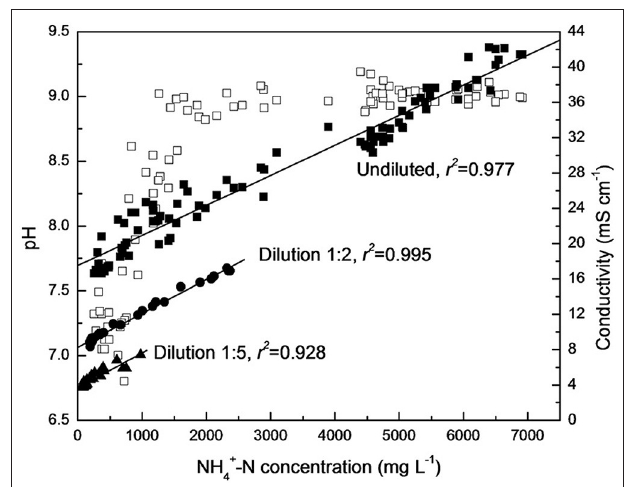
FIGURE 4 | Correlation of pH value ( (cid:3) ), conductivity ( N • (cid:4) ), and corresponding NH + 4 -N concentration during urine hydrolysis process. Reprinted with permission from Zhang et al. (2013a). Copyright © 2013 Taylor &